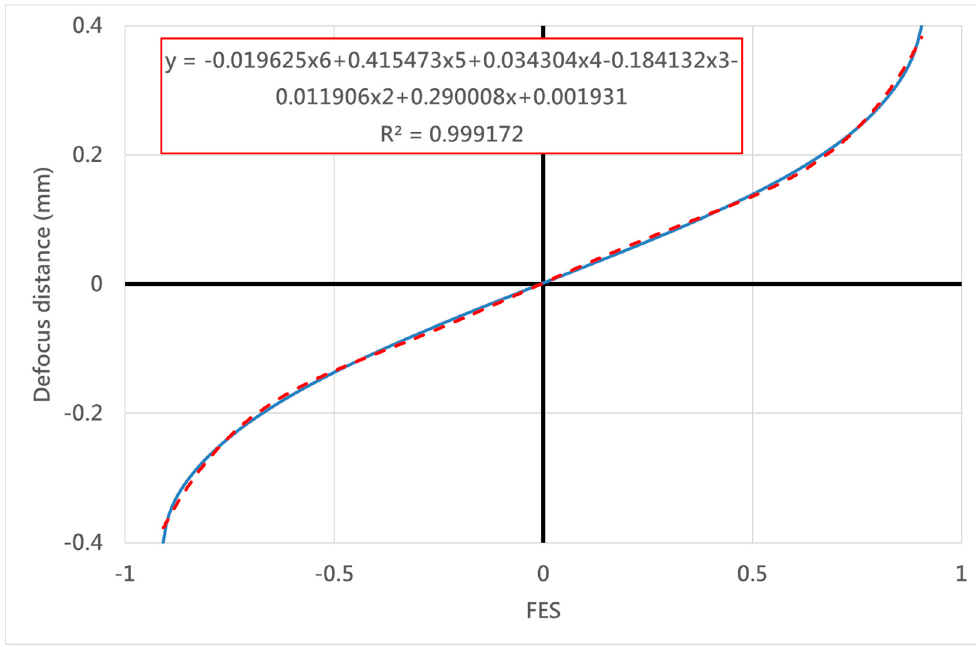
Figure 5. Simulation of the intensity signals from the two photodetectors.